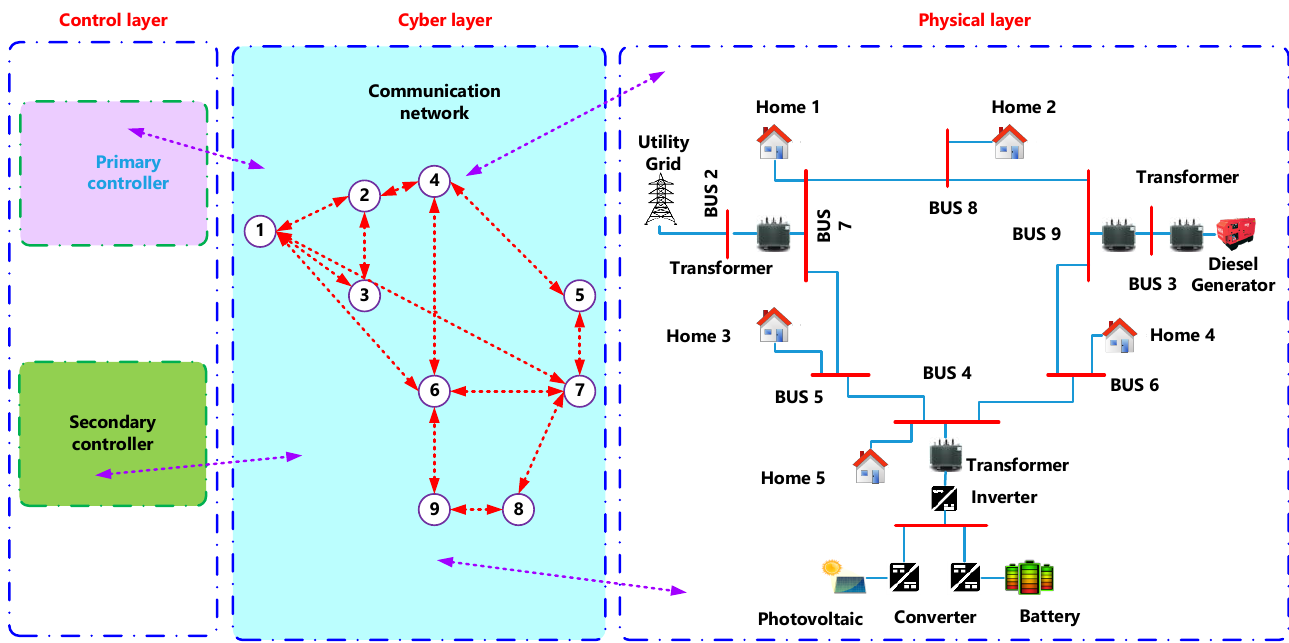
Figure 1. IEEE 9 bus system, with renewable energy sources and communication system.